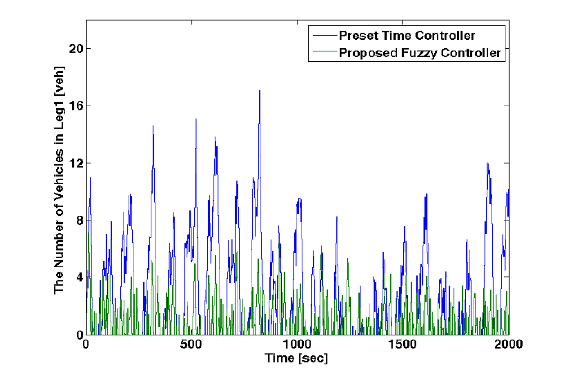
Figure 11. The number of vehicles in Leg1